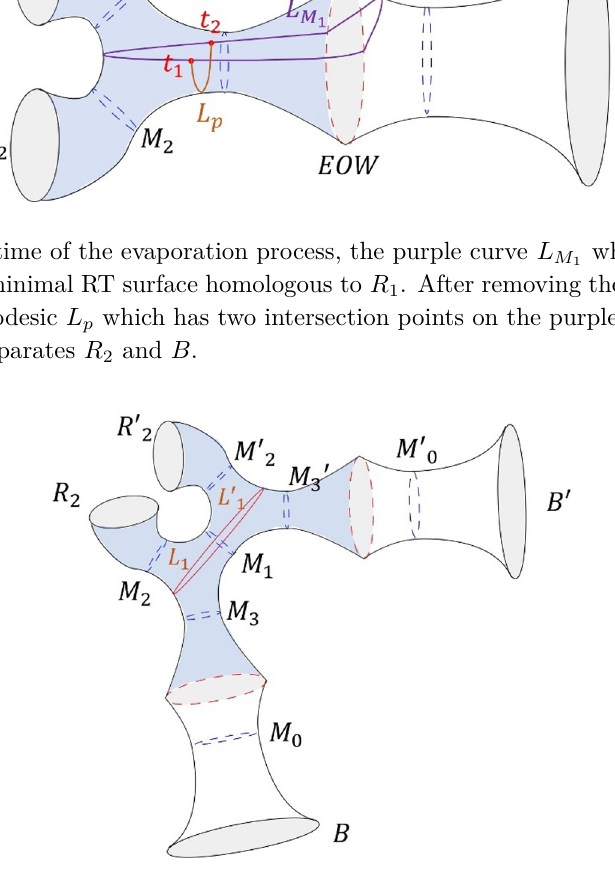
Figure 14 . The purification geometry after tracing out R 1